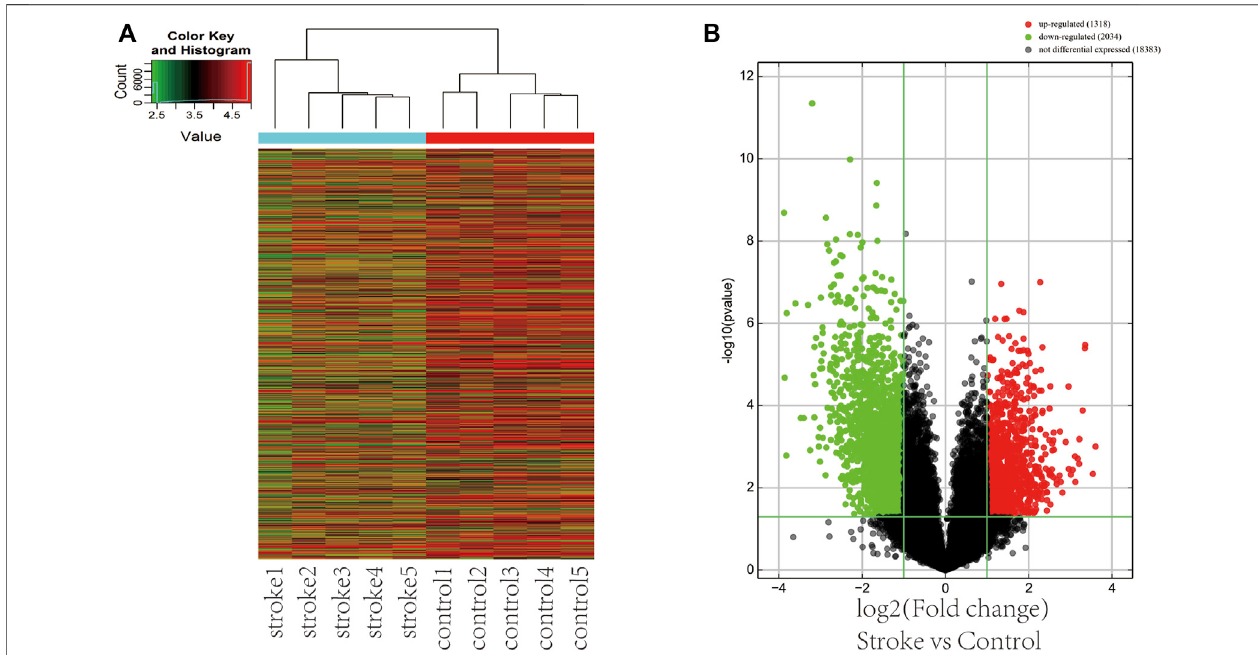
FIGURE1| TheDElncRNAs amongischemic strokepatientsversusnon-strokecontrols. (A) HierarchicalclusteringshowsdifferentlncRNAexpressionsbetween strokeandnonstrokepatients. (B) VolcanoplotoftheDElncRNAsinstrokepatientsandnonstrokecontrols.Redpointsintheplotarestatisticallysigni fi cantdifferentially upregulated lncRNAs, while green represents downregulated lncRNAs.